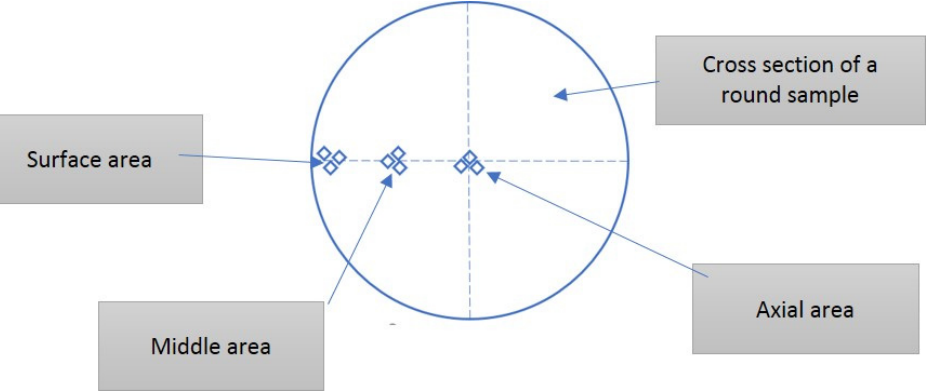
Figure 1. Conventional scheme of microhardness measurements on the cross section of a round bar sample.